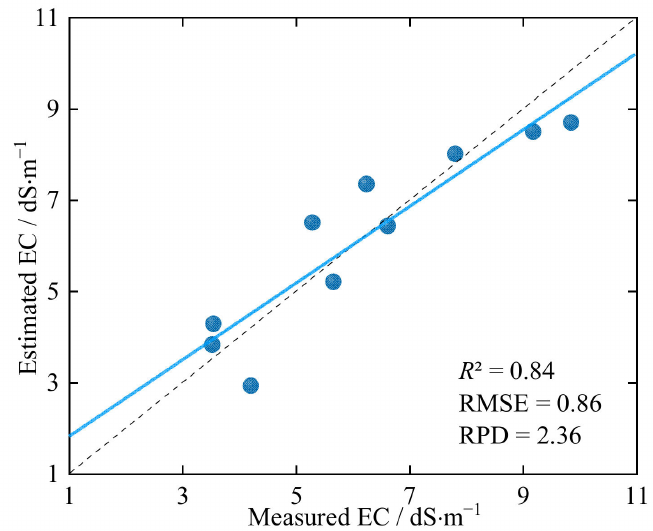
Figure 5. The scatterplots of measured EC derived from field survey versus estimated EC derived from modeling